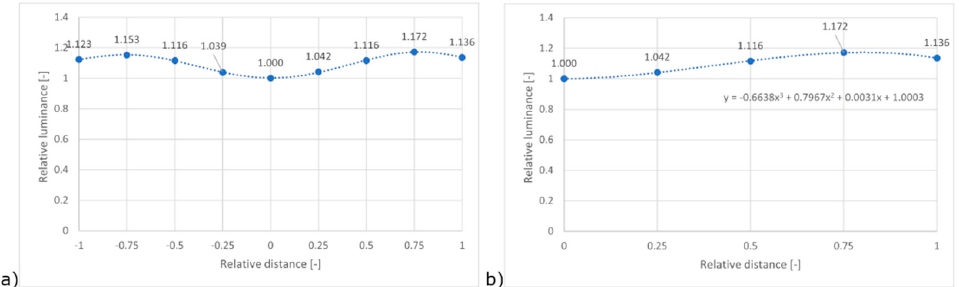
Figure 7. Lens shading effect pre-assessment: ( a ) relative distance 0 = centre of the image, ( b ) relative distance 1 = corner of the image.